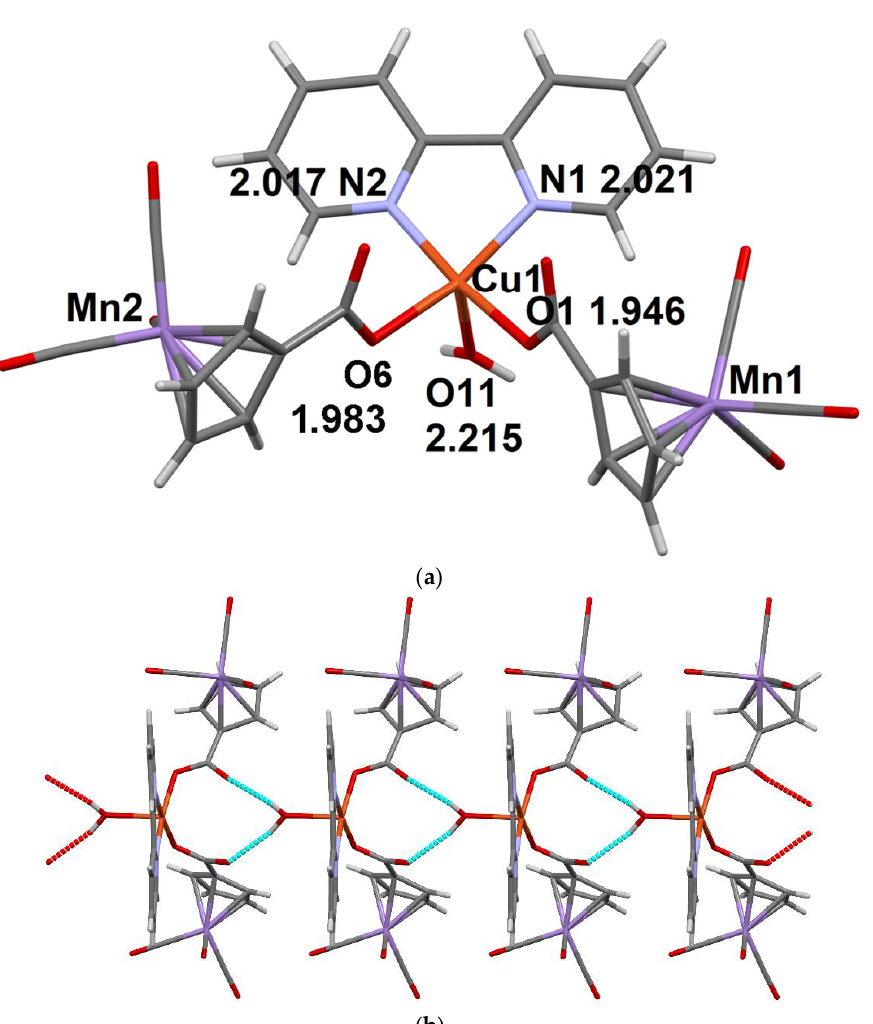
Figure 6. The molecular structural unit of compound 8 ( a ) and 1D-chain in its crystal structure ( b ). The distances between the coordinating atoms of the ligands and the Cu 2+ ion are given (Å).